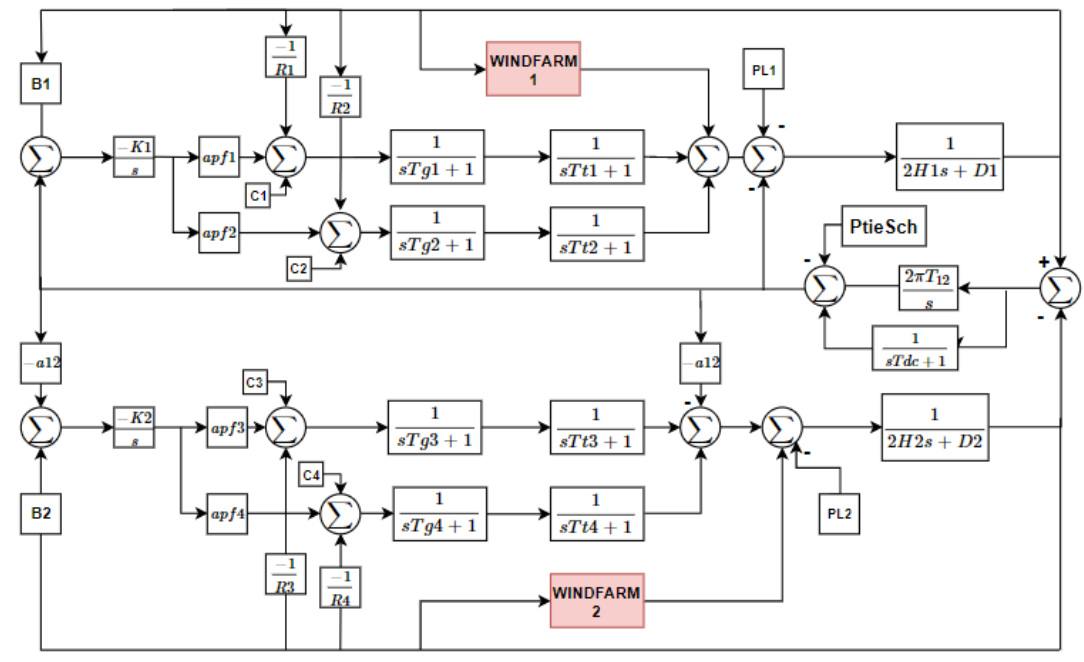
Figure 3. Frequency response model of a two area power system in a deregulated environment.